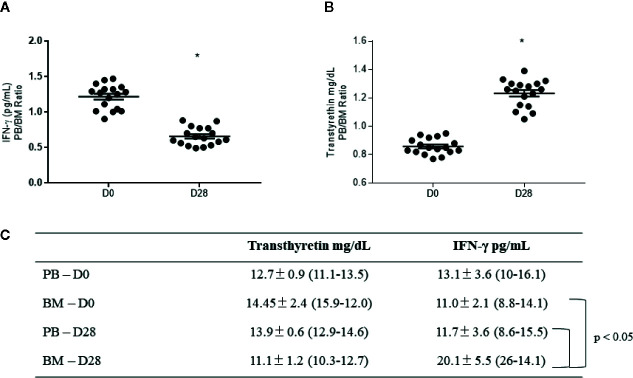
Validation of transthyretin and interferon-gamma (IFN-γ) levels in plasma samples from B-ALL patients. Peripheral blood (PB)/bone marrow (BM) ratio for (A) interferon-gamma and (B) transthyretin levels. In (C), specific levels for each protein at diagnosis (D0) and the end of the treatment (D28), represented as mean ± standard error of the mean (min-max). * indicates statistical significance, p < 0.05.